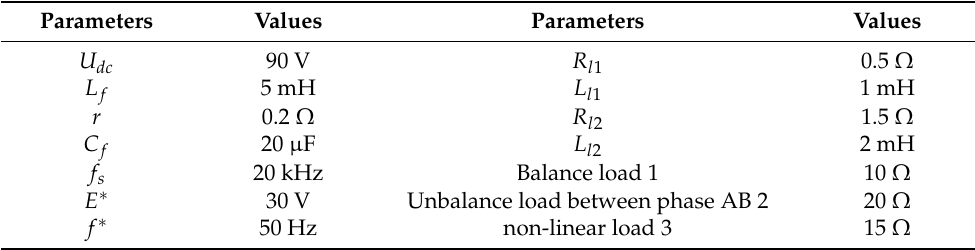
Figure 10. Experimental hardware: ( a ) Parallel inverters; ( b ) loads. Table 5. Experiment parameters.